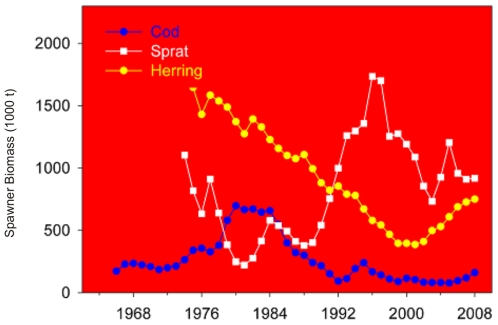
Spawner biomass of cod, herring, and sprat in the Baltic Sea (ICES management subdivisions 25–32, 25–29 (excluding the Gulf of Riga) and 22–32, respectively).Data: [137].